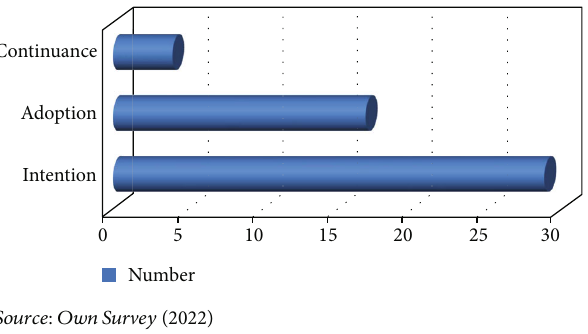
Figure 9: Online consumer behavior studies by center of